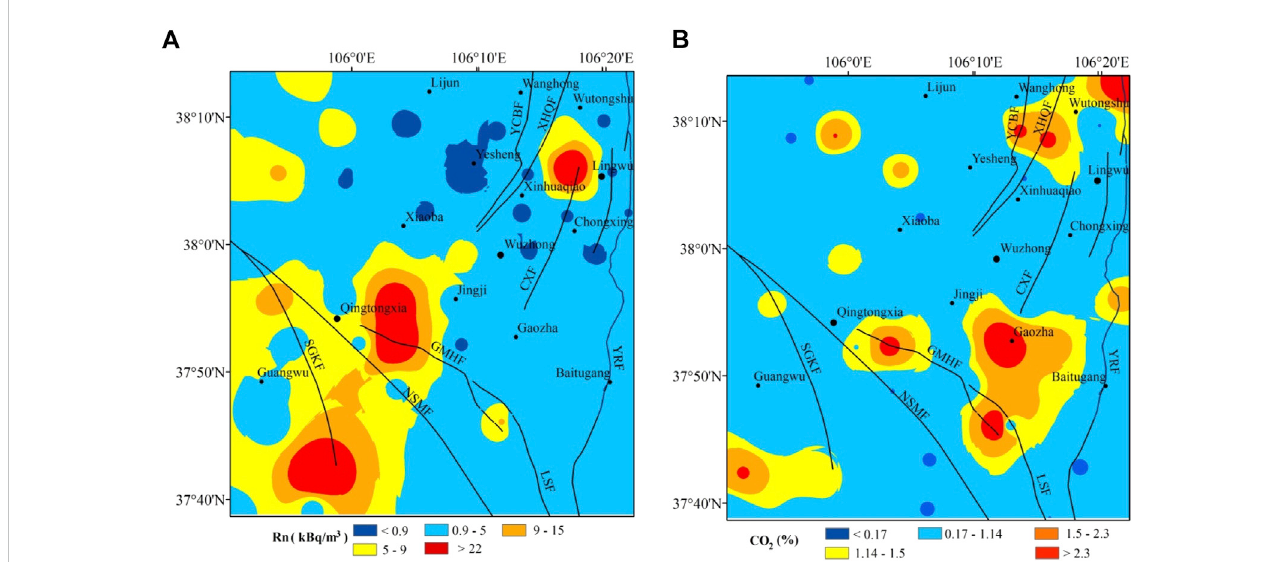
FIGURE 3 Spatial distribution of (A) Rn and (B) CO 2 concentrations in the Wuzhong – Lingwu area.